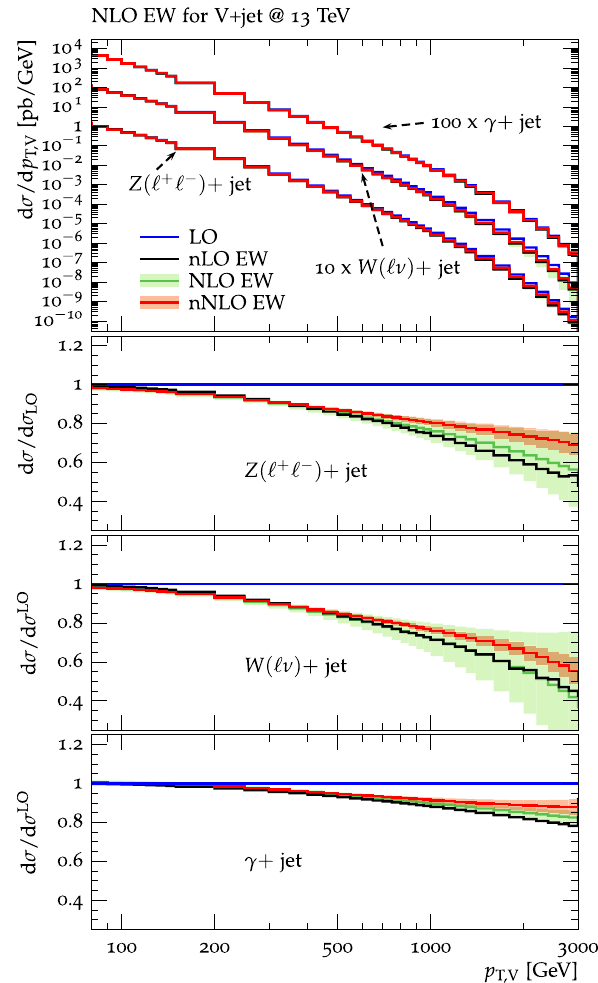
Fig. 9 Higher-order EW predictions and uncertainties for different pp → V + jet processes at 13TeV. The main frame displays absolute predictions at LO (blue), NLO EW (green) and nNLO EW (red), as well as NLL Sudakov logarithms at NLO (black), which are denoted as nLO EW. In the ratio plots all results are normalized to LO. Uncertainties at nNLO EW (red band) are evaluated by combining in quadrature the ( V ) corresponding variations δ ( i ) κ as defined in Eqs. (52), (53) and nNLOEW ( V ) (56) and for δ ( i ) κ in Eq. NLOEW